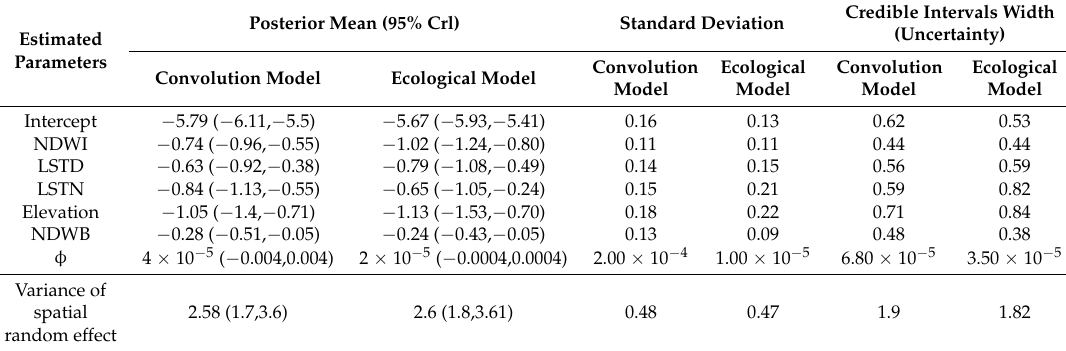
Table 2. Estimated regression coefficients (mean and 95% credible